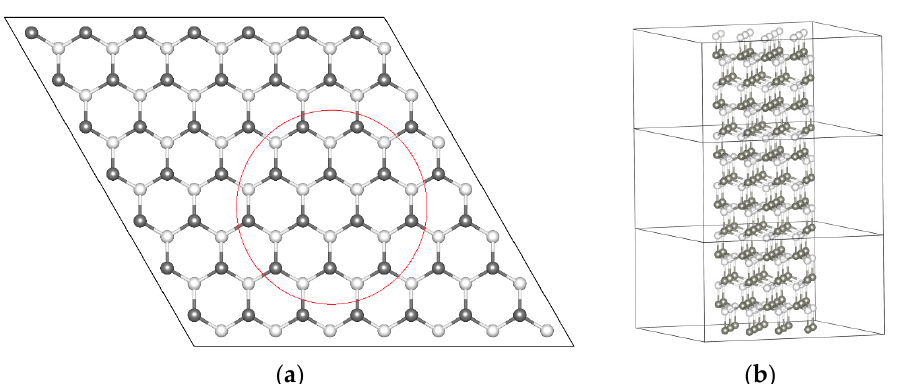
Figure 1. ( a ) Top view of a 7 × 7 × 2 ZnO nanowire supercell, ( b ) Periodic structure of Zn 48 O 48 nanowire supercell along the periodic structure along [0001] direction (white and black circles represent oxygen and zinc atoms, respectively).